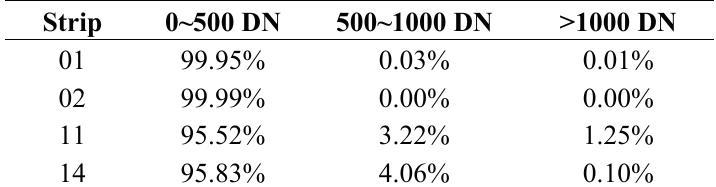
Table 1. Number of amplitude values by percent for the four strips in the study